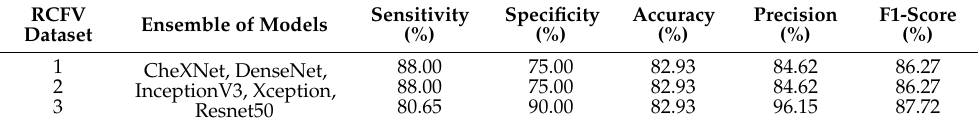
Table 12. Final ensemble learning uses multi-weighted DL models on three different